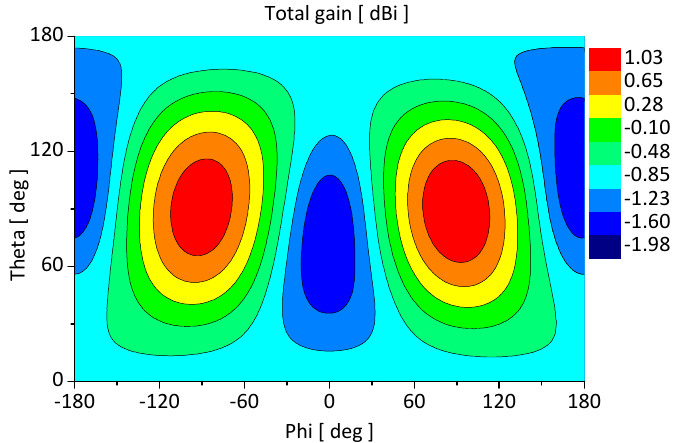
Figure 5. Simulation result of a gain deviation over the entire space at the resonant frequency.